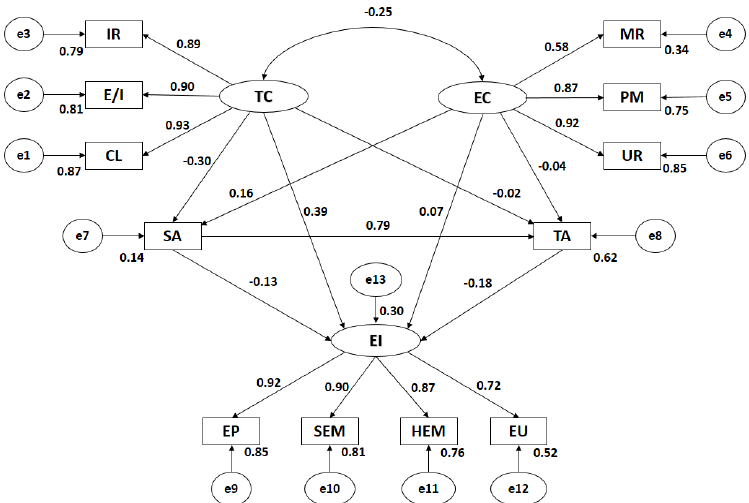
Figure 3. Structural equation modelling in team sports. Note: TC, Task Climate; CL, Cooperative Learning ; E/I, Effort/Improvement; IR, Important Role; EC, Ego Climate; MR, Member Rivalry; PM, Punishment for Mistakes; UR, Unequal Recognition; SA, State Anxiety; TA, Trait Anxiety; EI, Emotional Intelligence; HEM, Heteroemotional Management; SEM, Self ‐ emotional management; EP, Emotion Perception; EU, Emotion Utilisation.